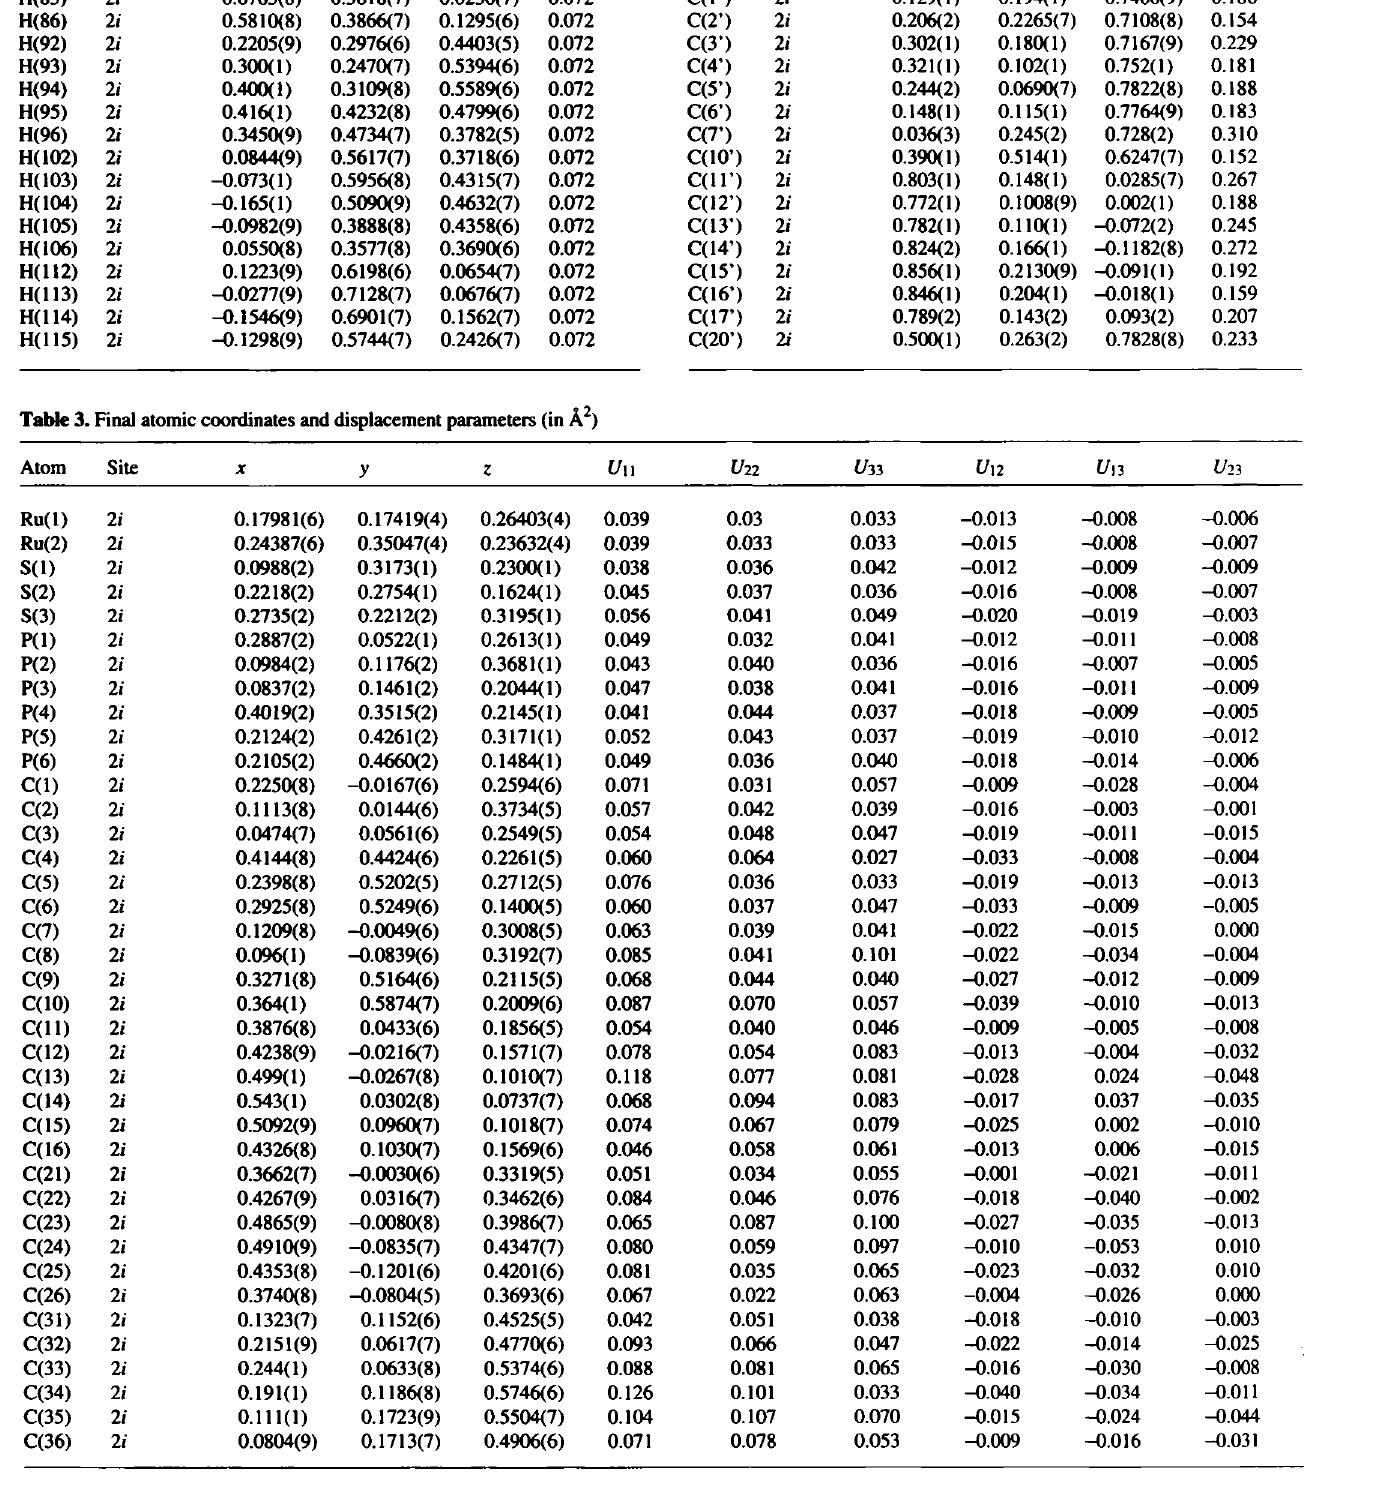
Table 3. Final atomic coordinates and displacement parameters (in Â})